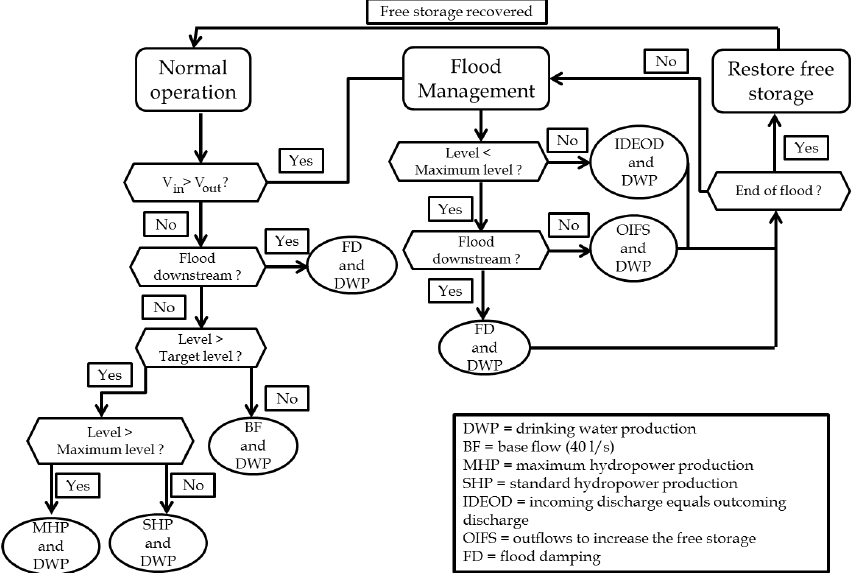
Figure 2. Principles of the reservoir operation rules.